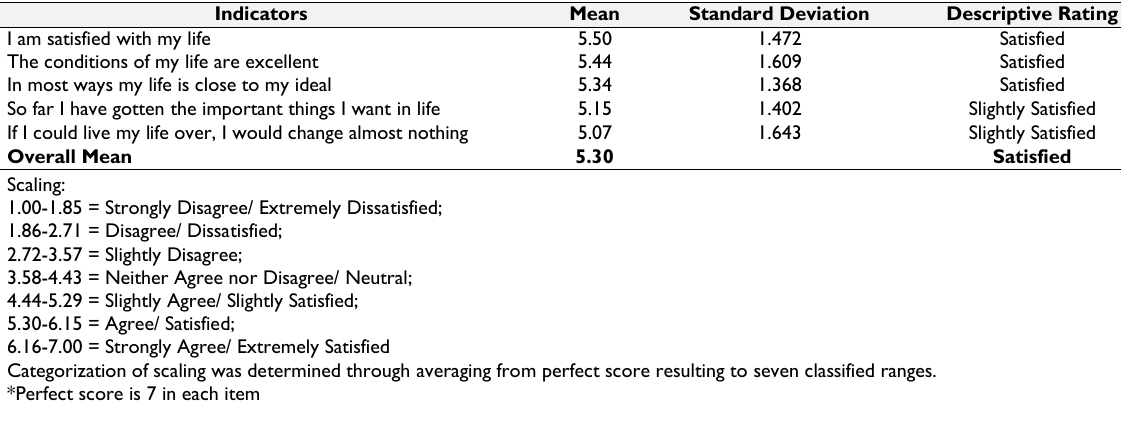
Table 4 C orrelation between the older adults’ self -control and their life